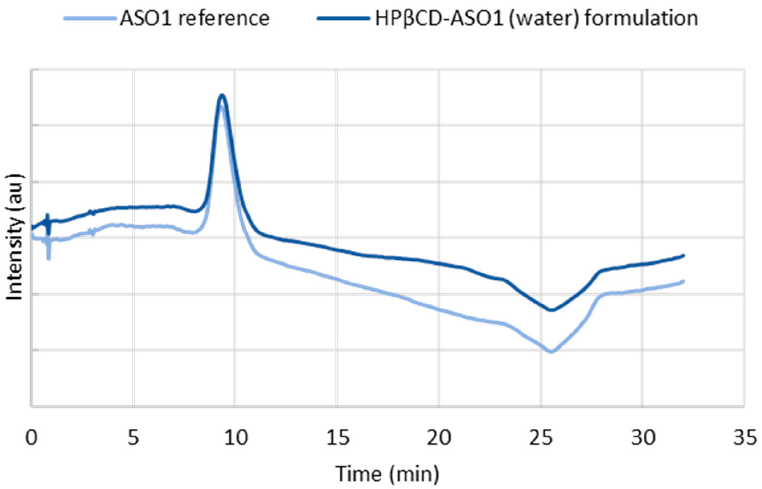
Figure A1. RP-HPLC chromatogram of ASO1 reference and HP β CD-ASO1 (water) formulation.